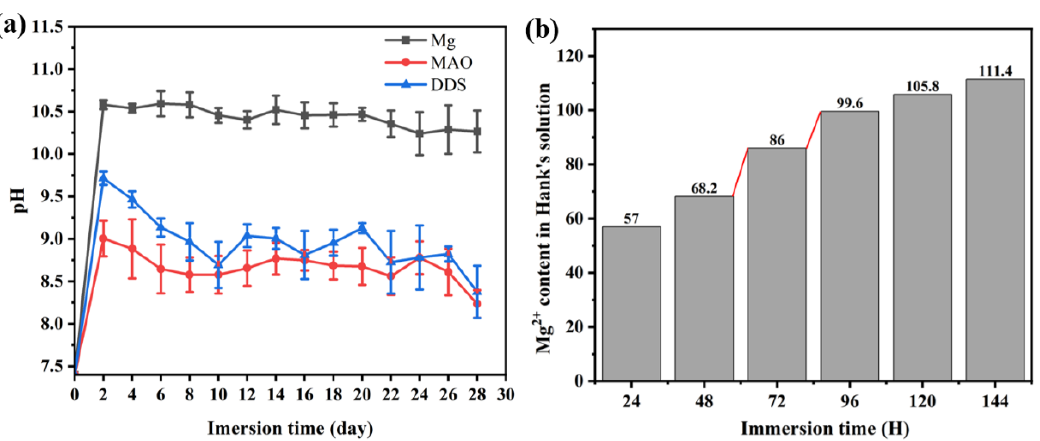
Figure 3. Change of pH value of Mg alloy, Mg-based MAO alloy, and Mg-based MAO-MT-PLGA DDS afte r immersion in Hank’s solution for 28 days ( a ) and cumulative Mg 2+ content of Mg-based MAO-MT-PLGA DDS in leaching solution for 144 h ( b ). The red lines in ( b ) shows a sudden increase in Mg 2+ release .